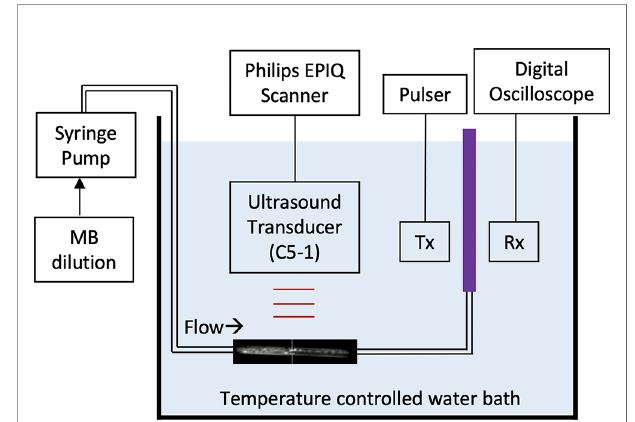
FIGURE 1 | Schematic of the system used for broadband acoustic attenuation spectroscopy. The purple region denotes the CLINIcell sample chamber. Tx and Rx denotes the transmitting and receiving transducers,